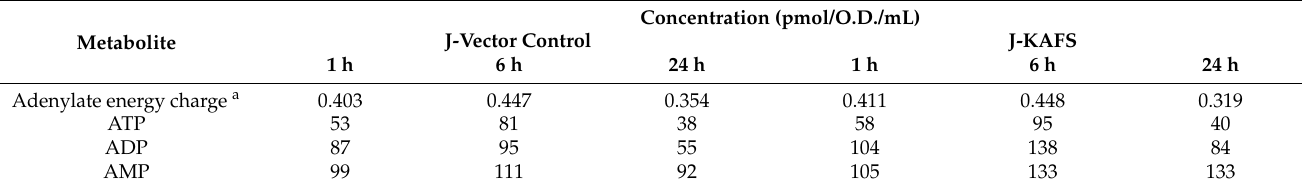
Table 5. Concentrations of ATP, ADP, and AMP in the E. coli J-vector control strain and J-KAFS strain under anaerobic respiration